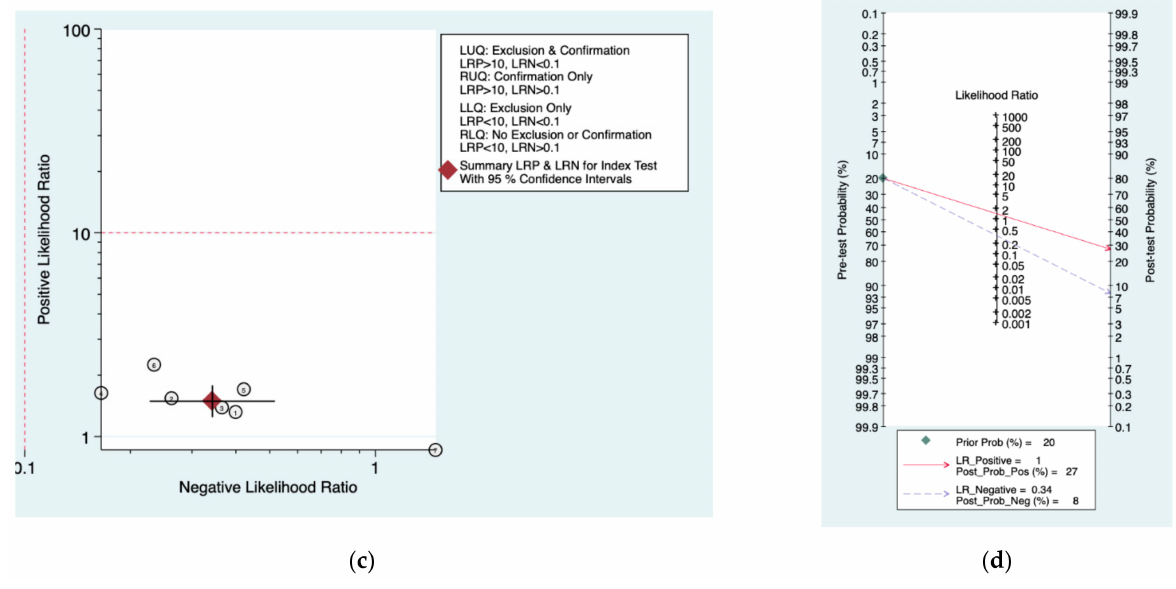
Figure 8. Meta‑analysis of Oxford protocol. ( a ) Forrest plot of pooled sensitivity and